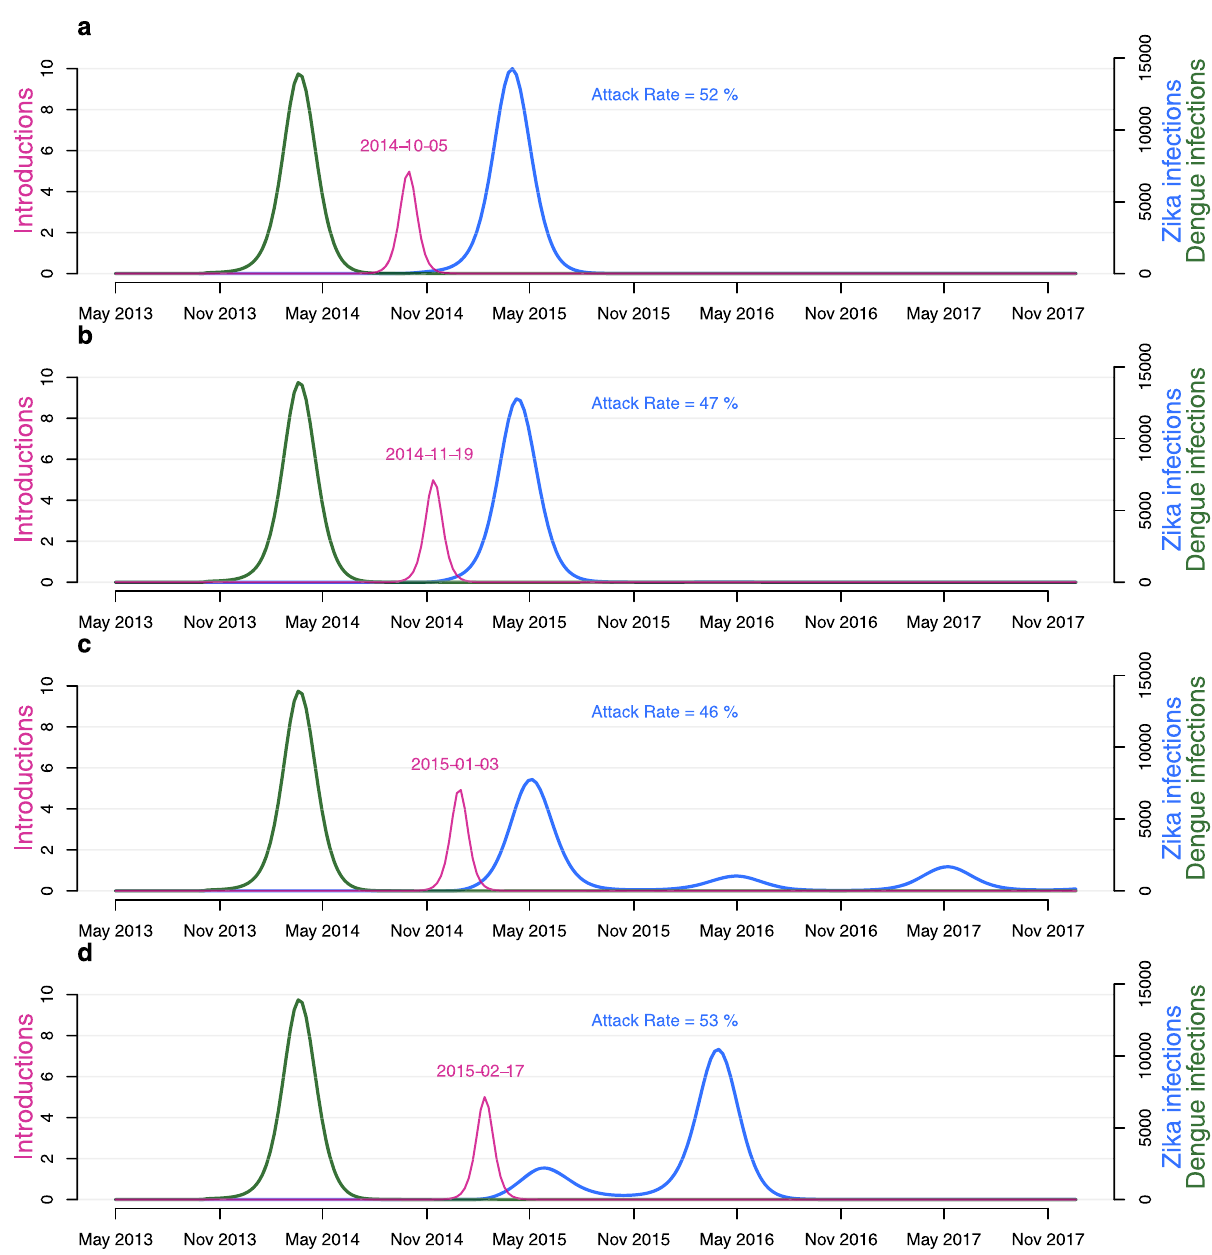
Fig. 3 Transmission dynamics by varying introduction time. Simulated ZIKV outbreaks using the maximum a posteriori parameter set and adjusting the midpoint of the introduction of ZIKV infectious individuals. Changing the introduction time alone can vary resulting outbreak dynamics between low level circulation over multiple years to large single-season epidemics. The modelled DENV-3 infections during the 2013-14 epidemic is reproduced here for comparison. Introduction time centred around October 2014 ( a ), November 2014 ( b ), January 2015 ( c ), February 2015 ( d ). Blue line, model simulation for the prevalence of ZIKV infections (not cases). Green line, modelled DENV-3 2013 – 14 infections. Pink line, introduction of infectious individuals. The date of the midpoint of the introduction function is displayed in pink. The attack rate is equal to the sum of all ZIKV infections divided by the population size at the start of the outbreak, 342,000